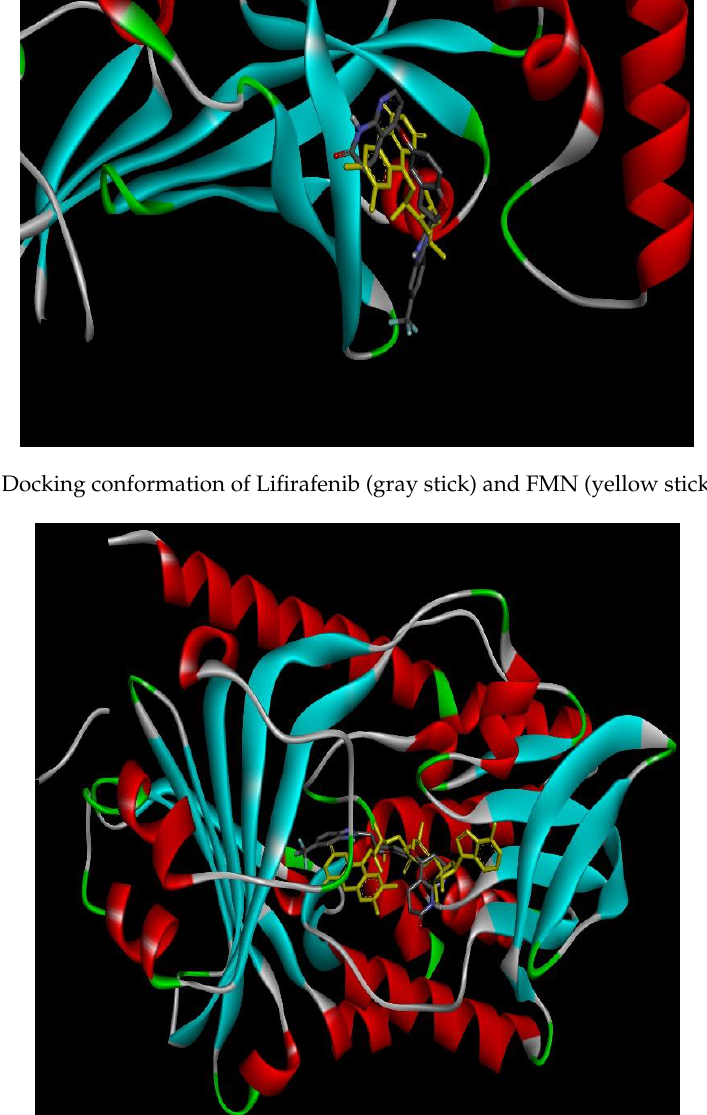
Figure 4. Docking conformation of Lifirafenib (gray stick) and FAD (yellow stick) in phzS.